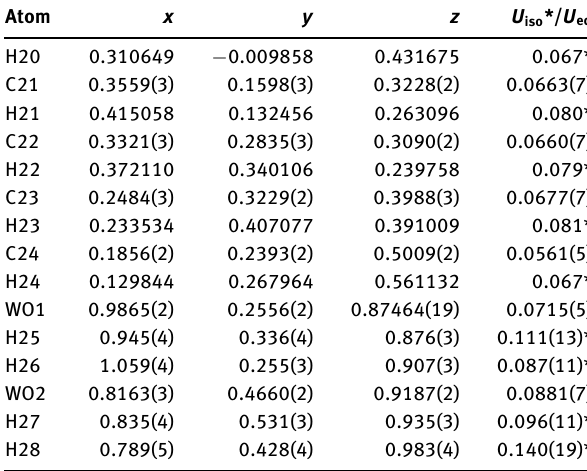
Table 2: Fractional atomic coordinates and isotropic or equivalent isotropic displacement parameters (Å 2